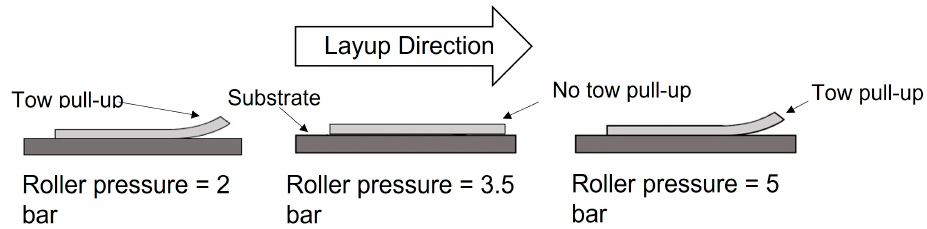
Figure 11. Schematic showing the effect of roller pressure on tow lift-up.